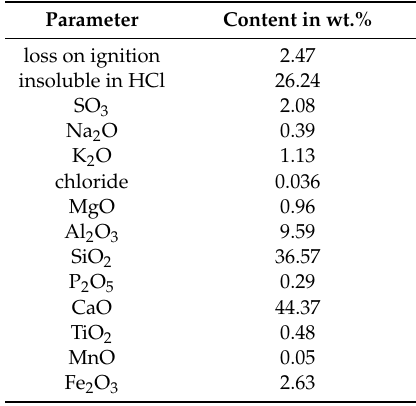
Table 3. Main components of the < 125 µ m fraction of the concrete ready mix.